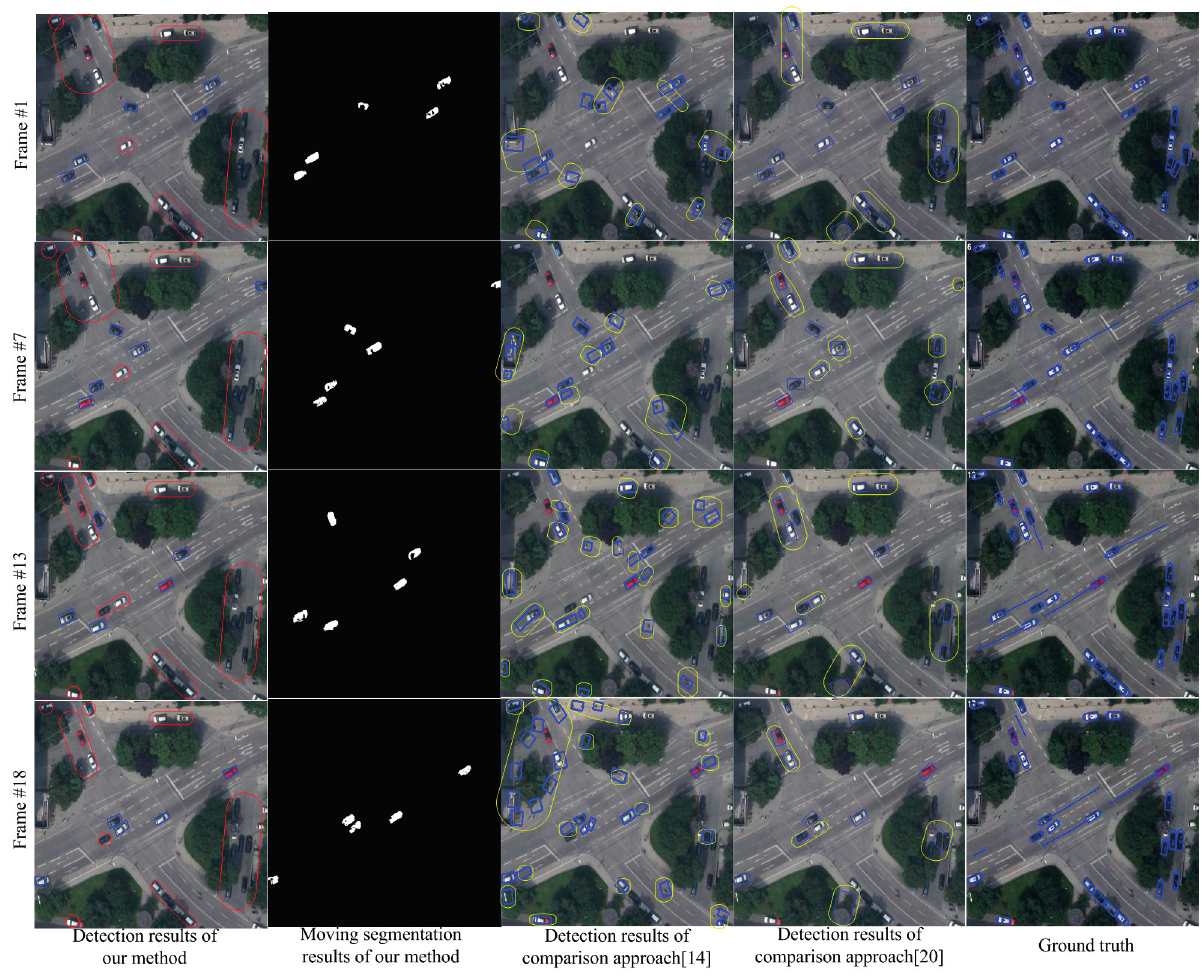
Figure 5. Detection comparisons in scenarios with many